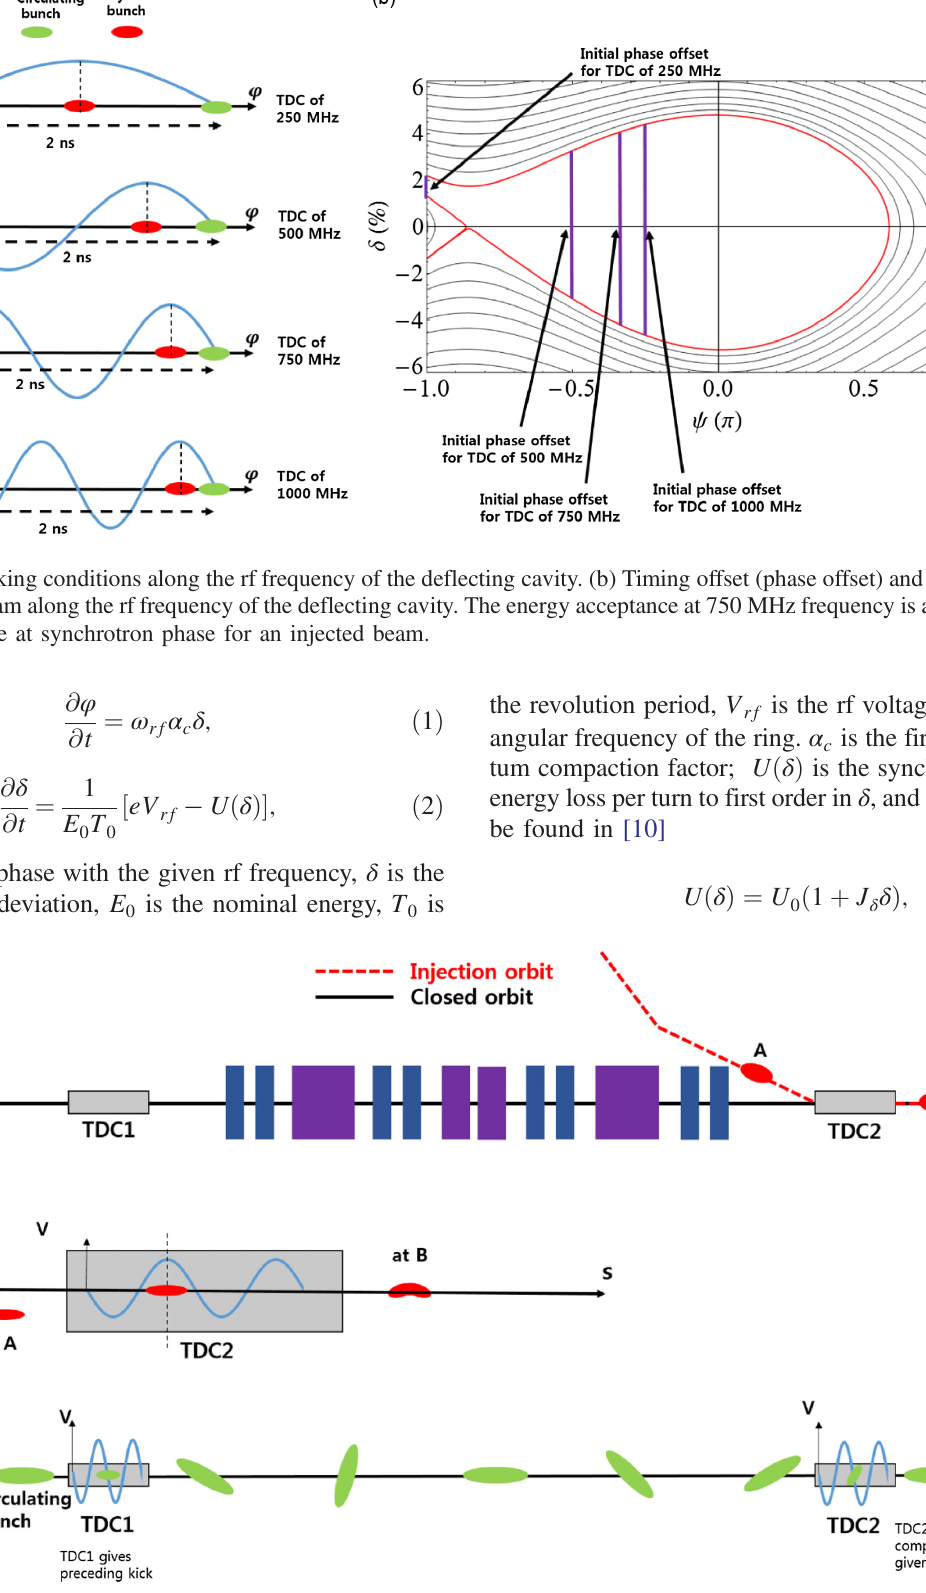
FIG. 2. Schematics for the working principle of on-axis injection with two deflecting cavities. (a)-(b) The second TDC kicks the injected beam on-axis. (c) The two TDCs crab and uncrab the stored beam (circulating